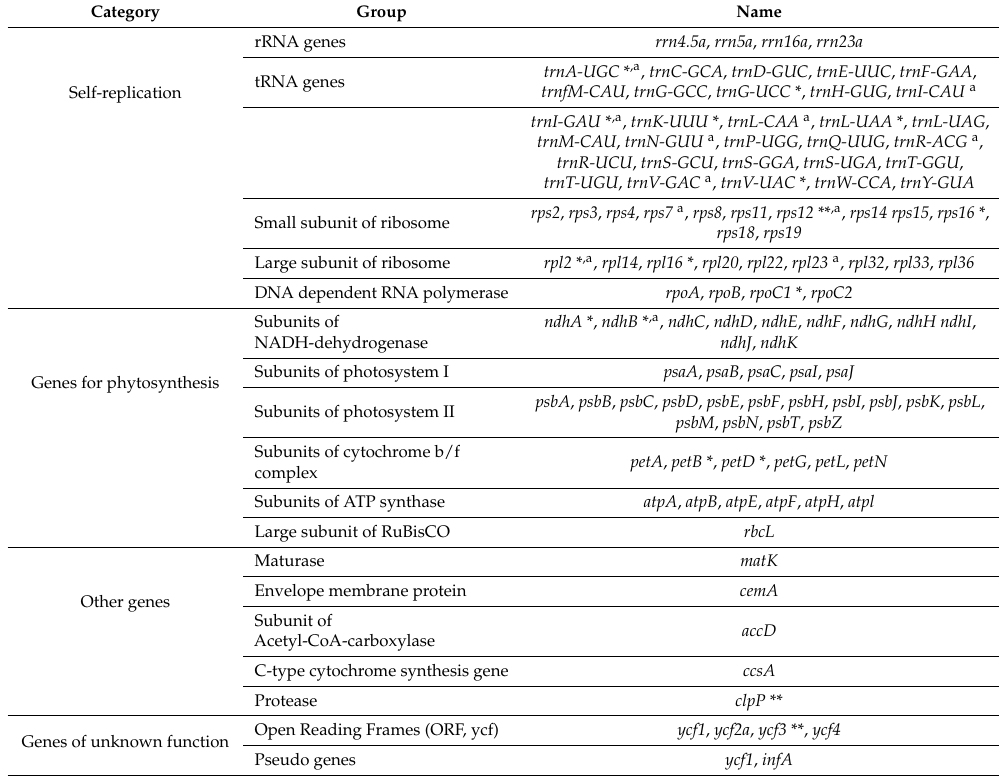
Table 2. List of genes encoded by the four Sanguisorba chloroplast genomes.